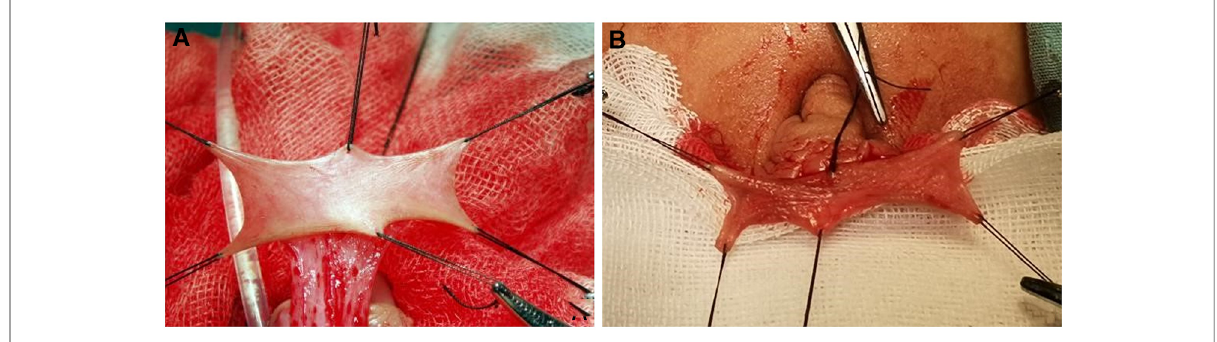
FIGURE 3 Preputial island fl ap condition. ( A ) In good condition, the fl ap is smooth and presents good elasticity. ( B ) In bad condition, the fl ap is stiff and not